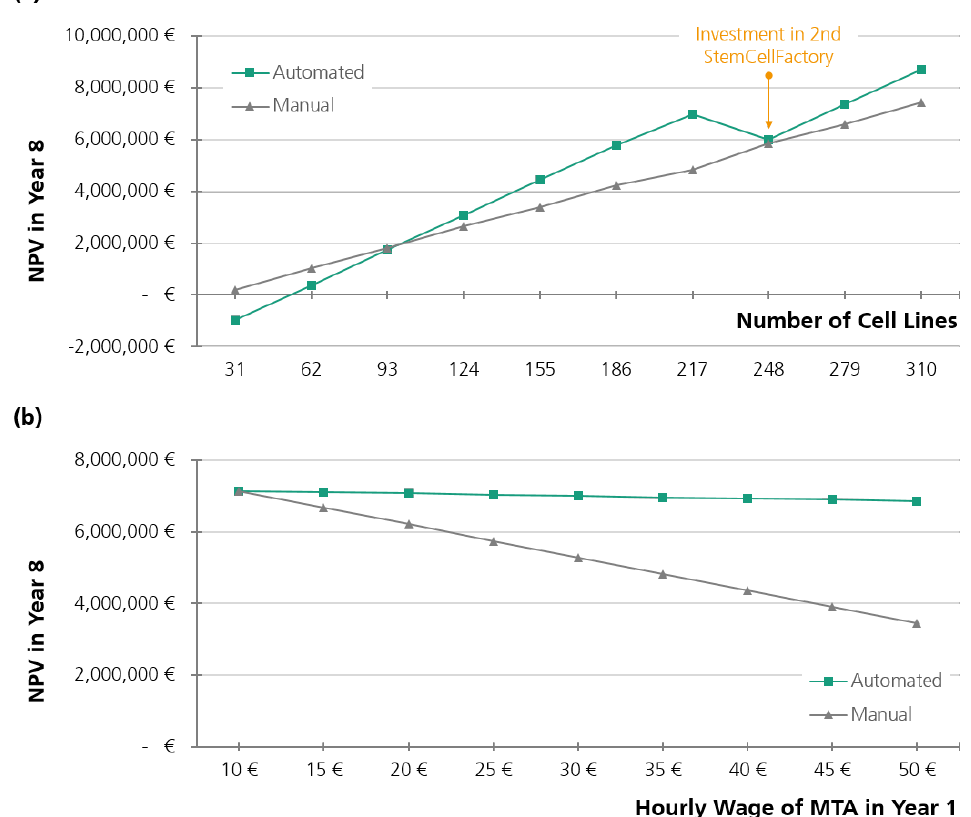
Figure 5. Sensitivity analysis of automated and manual iPSC production.